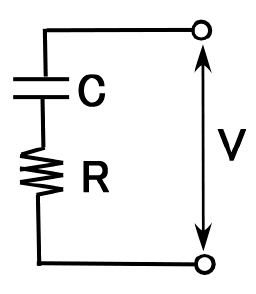
Figure 1. Equivalent electric circuit with capacitance C and resistance R of a magnetic compound fluid (MCF) rubber solar cell.